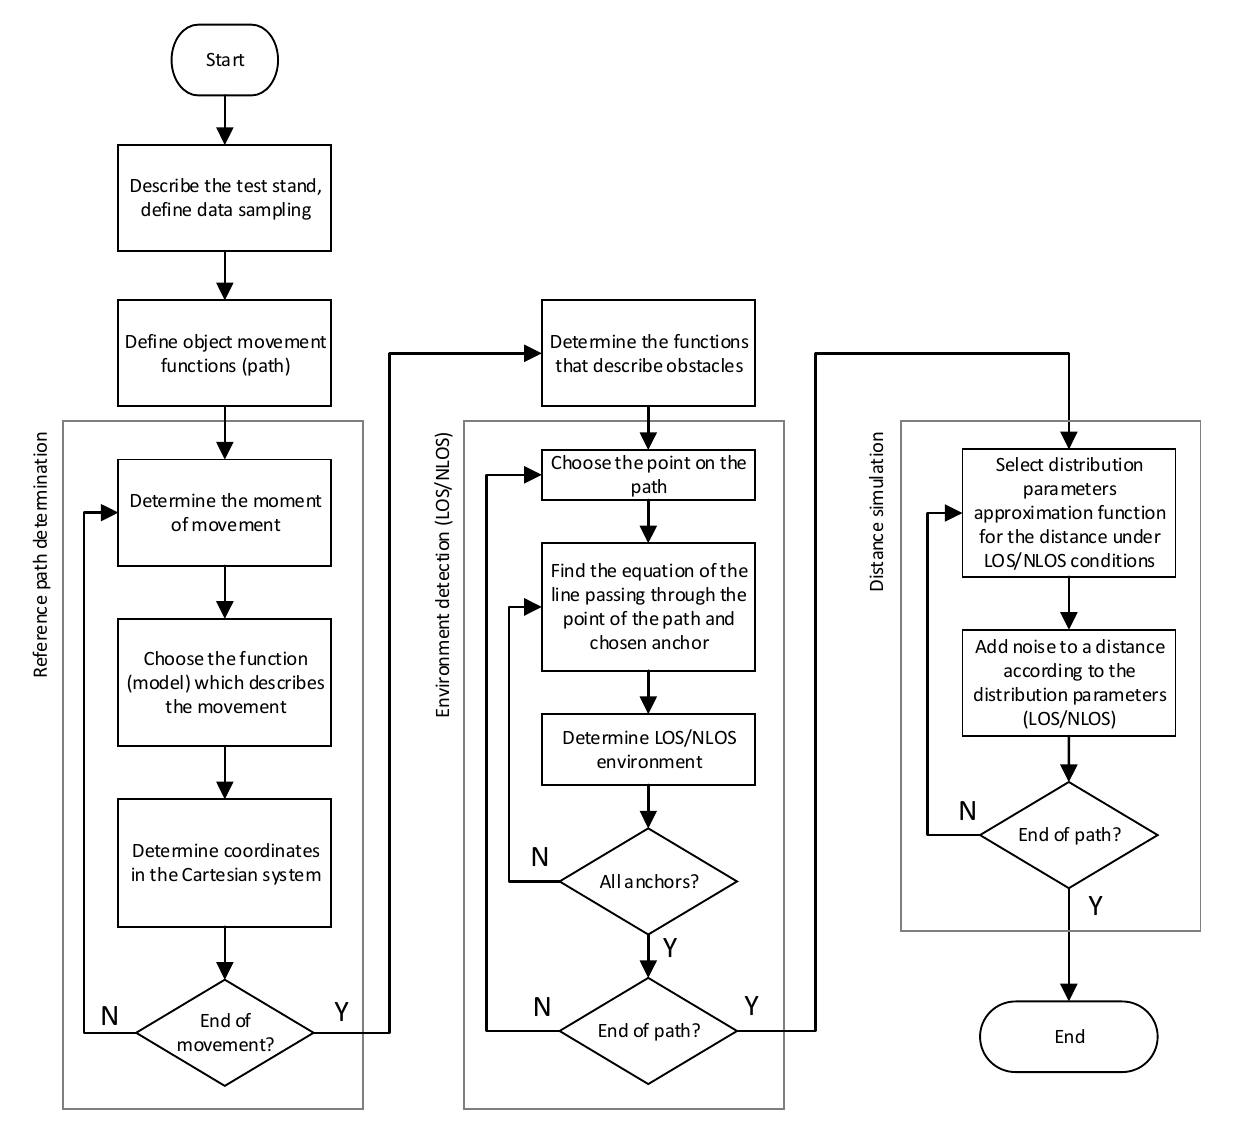
Figure 13. Block diagram of the simulator.